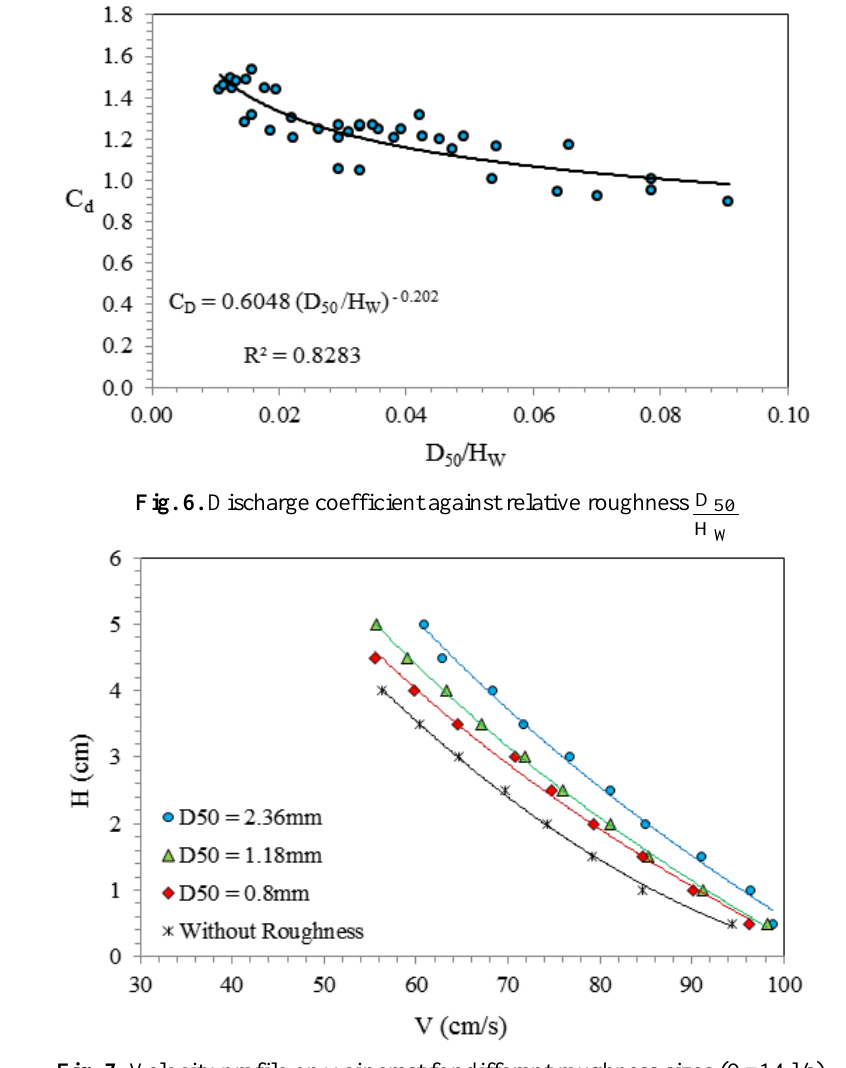
Fig. 7. Velocity profile on weir crest for different roughness sizes (Q=14